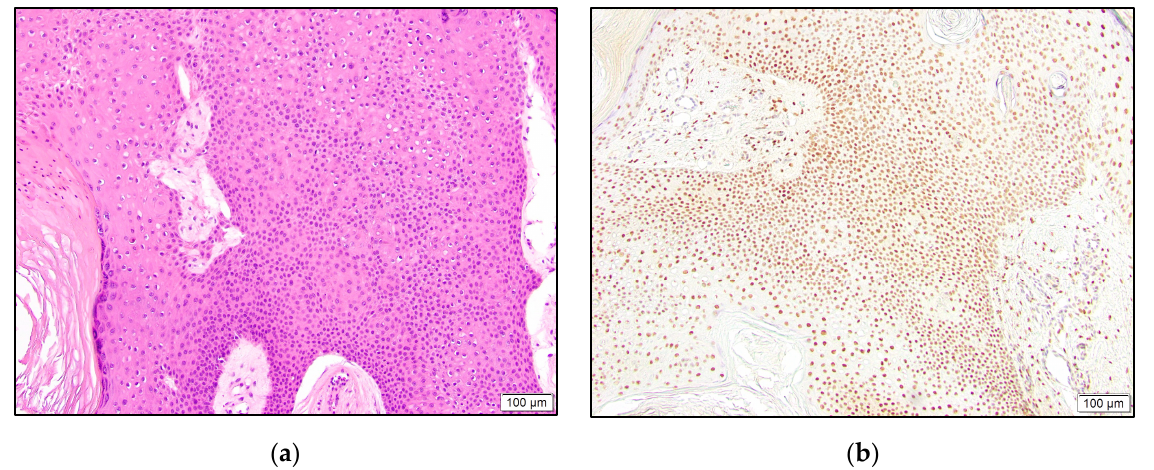
Figure 5. Poroma with proliferation of monotonous basophilic cells ( a ) and high positive TRPS1 expression ( b ). All MAC and syringoma cases were negative for TRPS1 expression (Figure 6).